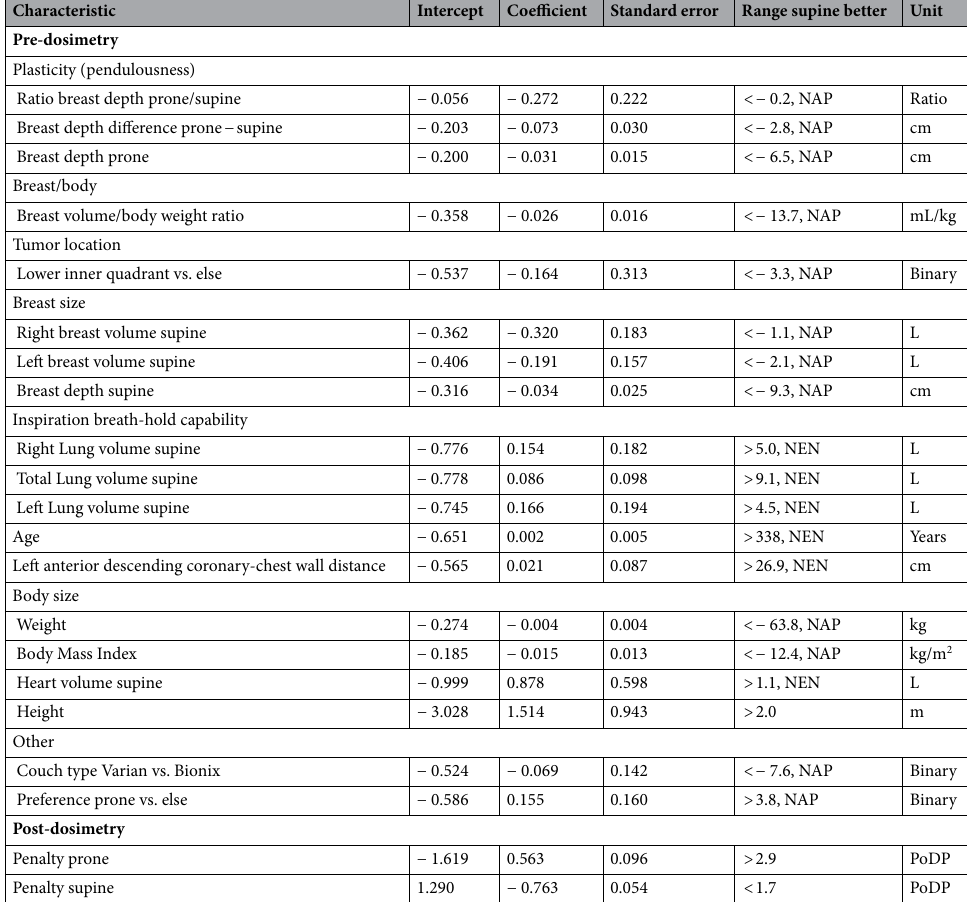
Table 3. Robust linear regression predictors of a supine advantage. Range Supine Better computed from the intercept and coefficient to predict when the penalty score changes in favor of supine. NAP not attainable physically, e.g. length < 0. NEN not expected normally, e.g. age > 338 years. PoDP percent of dose